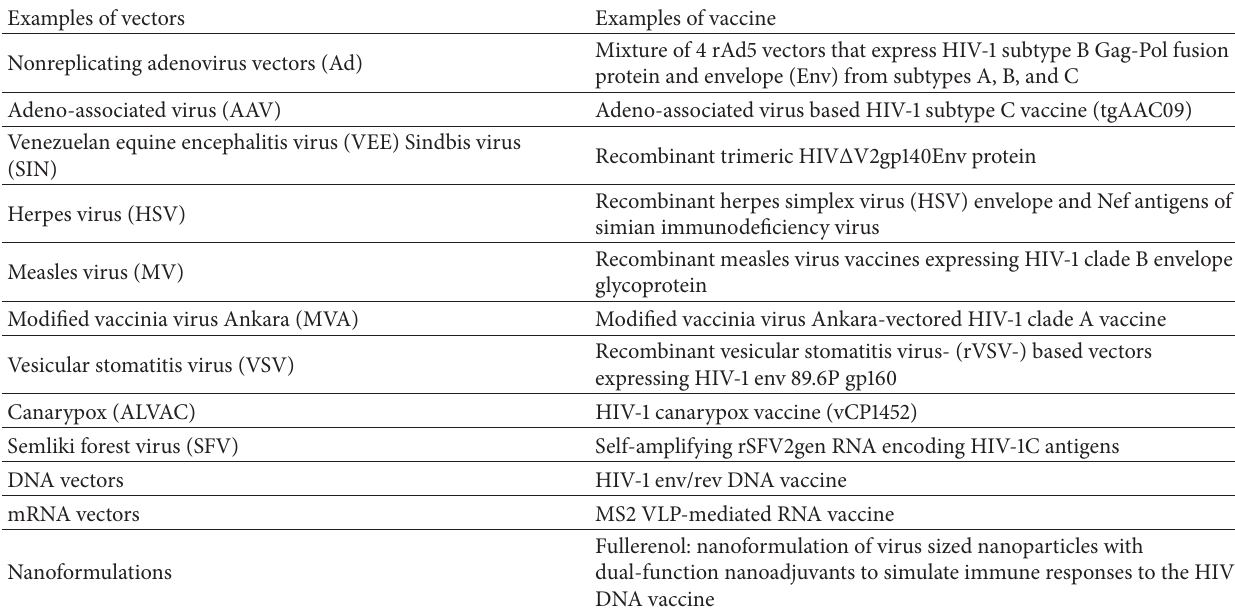
Table 3: Examples of viral vectors and alternative HIV vaccine delivery